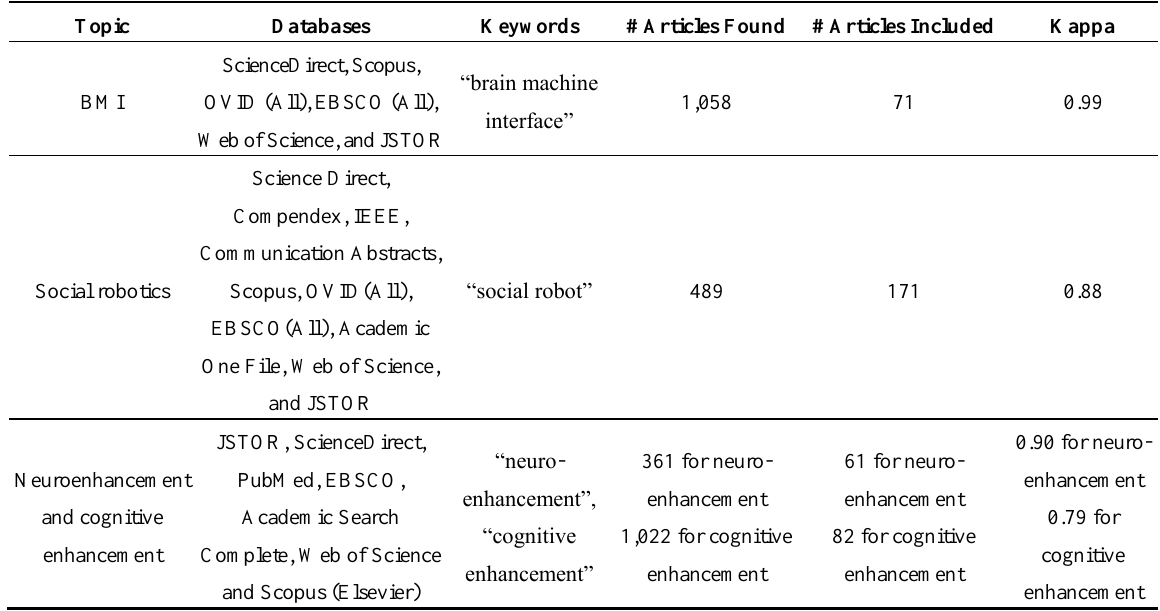
Table 1. Literature search